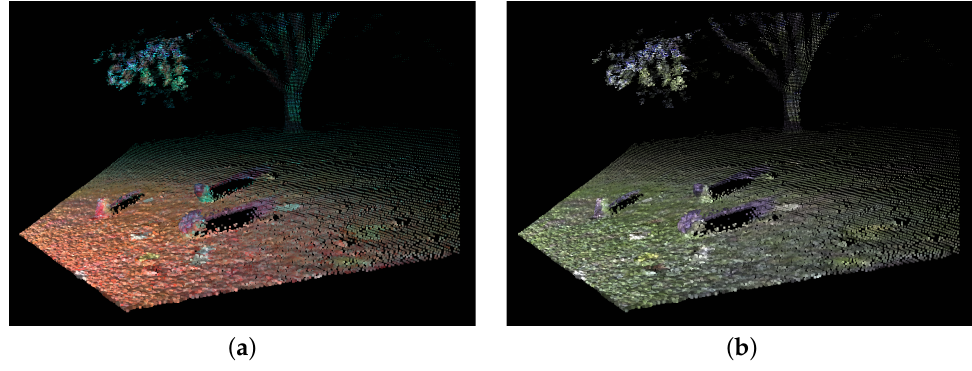
Figure 12. Point cloud of camera-LIDAR fusion showing the RGB intensity values of each 3-D point ( b ); and a multispectral view of the point cloud showing R, G and NIR channels ( a ).